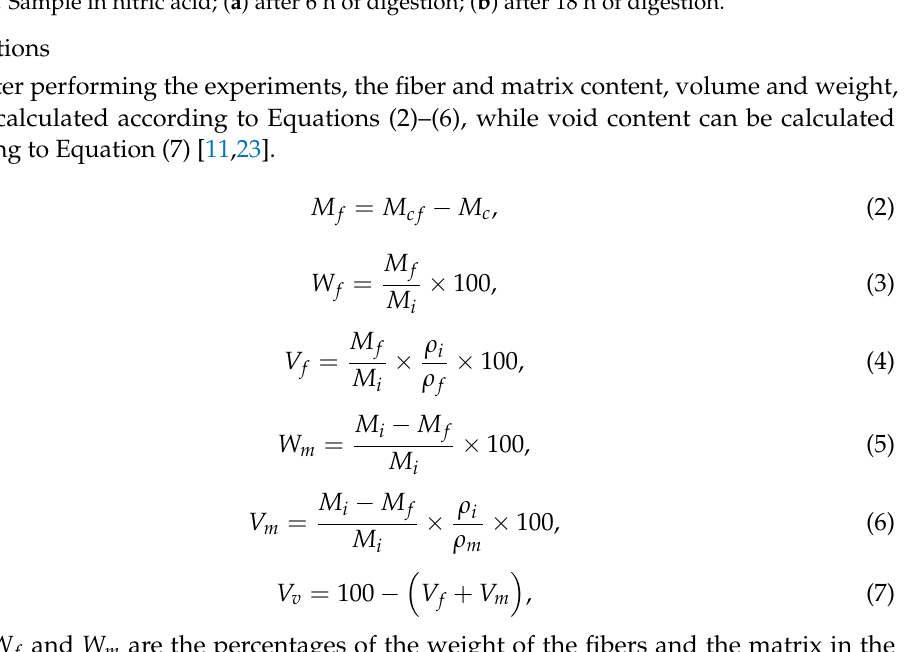
Figure 5. Sample in nitric acid; ( a ) after 6 h of digestion; ( b ) after 18 h of digestion.